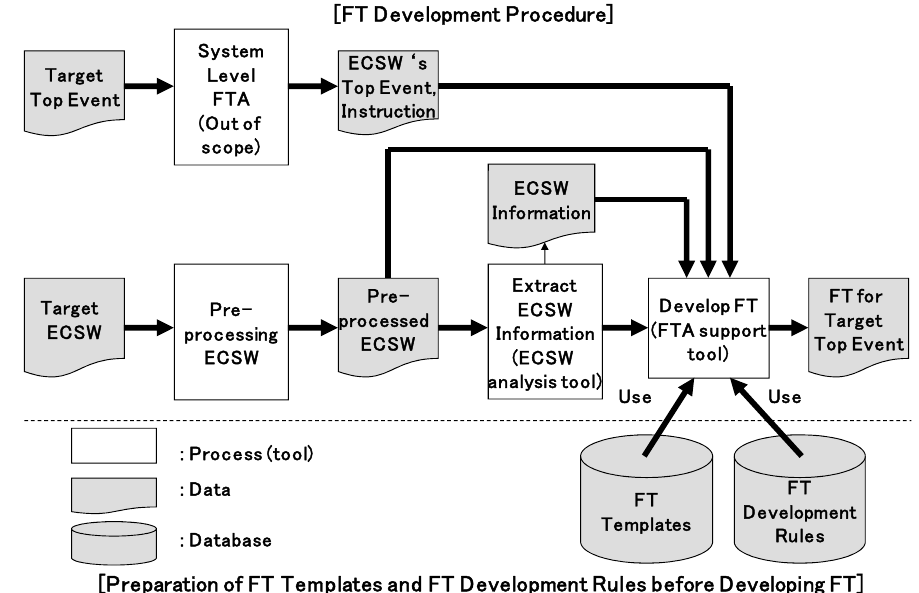
Figure 2. Outline of the proposed method.